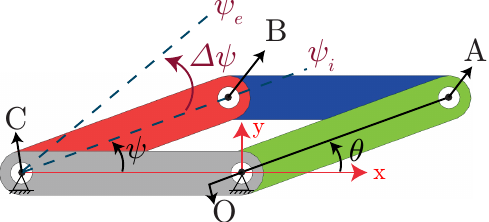
Figure 3. The output link BC requires a movement from ψ i to ψ e , which is performed by moving θ over a design-specific angle.